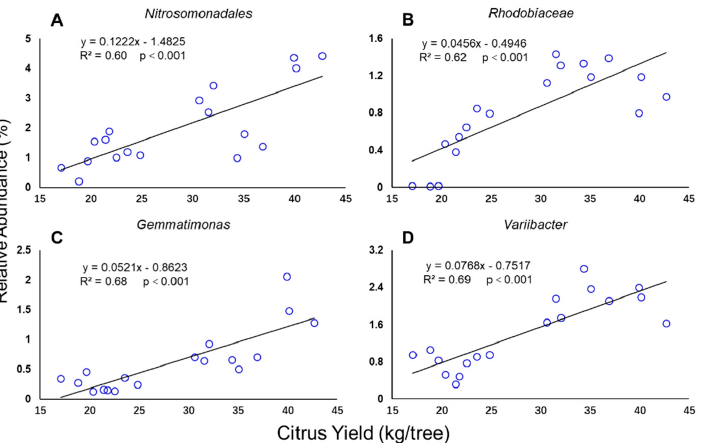
Figure 7. Relationships between citrus yields and the relative abundance of bacterial taxa ( A – D ). Solid lines are regression fitting curves between citrus yields and the relative abundance of each bacterial taxa.